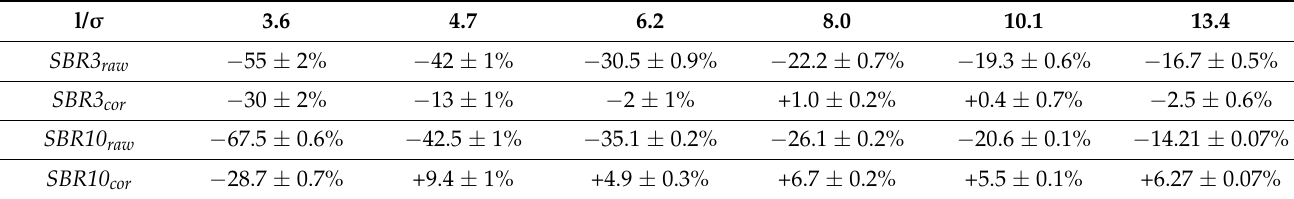
Table 7. Comparison of percentage of recovery for the different SBR. For both acquisitions, acquisition time was fixed at 4 min and the reconstruction algorithm was with TOF